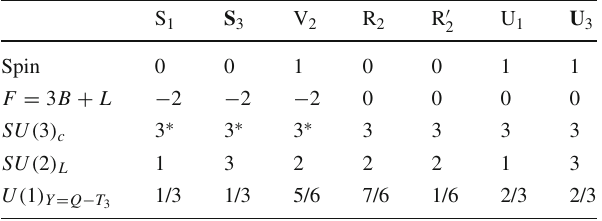
Table3 QuantumnumbersoftheLQswith SU ( 3 ) c × SU ( 2 ) L × U ( 1 ) Y invariant forms